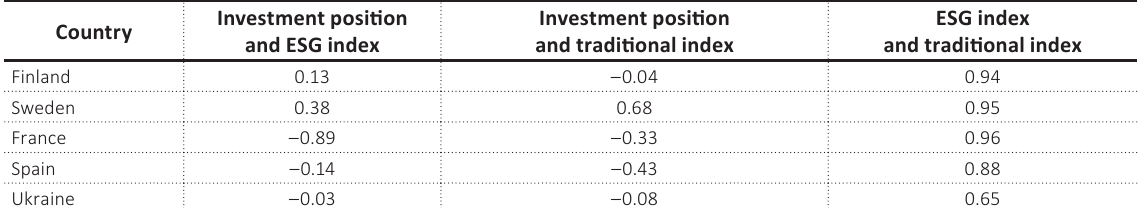
Table 5. Correlation analysis of the countries’ investment position, ESG and traditional indices